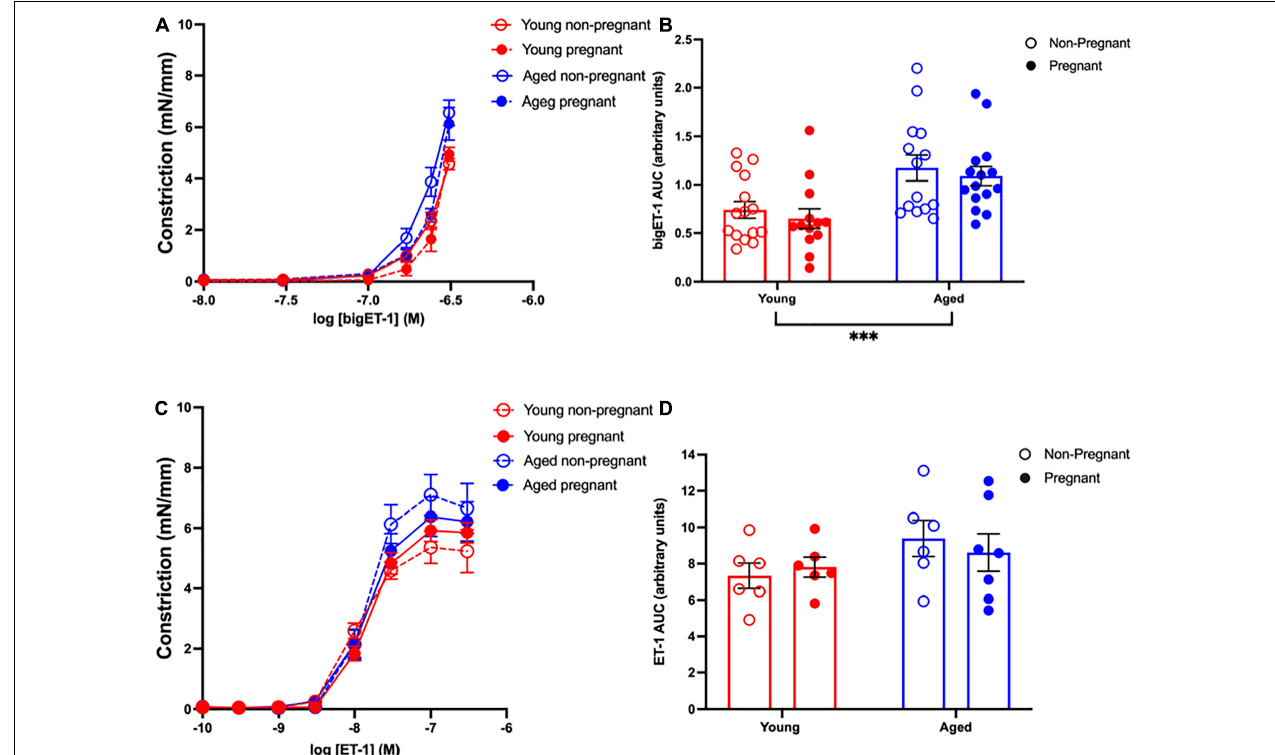
FIGURE 6 | Increased vascular responses to bigET-1 in aged non-pregnant and pregnant rats, and no changes in vascular responses to ET-1. (A,C) Vascular contraction responses to bigET-1 and ET-1 in mesenteric arteries of young (3–4 months; in red) and aged (9–9.5 months; in blue) pregnant (on gestational day 20; closed circles) and non-pregnant (age-matched; open circles) rats. (B,D) Data summaries of area under the curve (AUC) of the bigET-1 (B) and ET-1 (D) responses. Data are presented as mean ± SEM; analyzed by two-way ANOVA with Sidak’s multiple comparisons post hoc test; ∗∗∗ p < 0.001; n = 6–16/group.